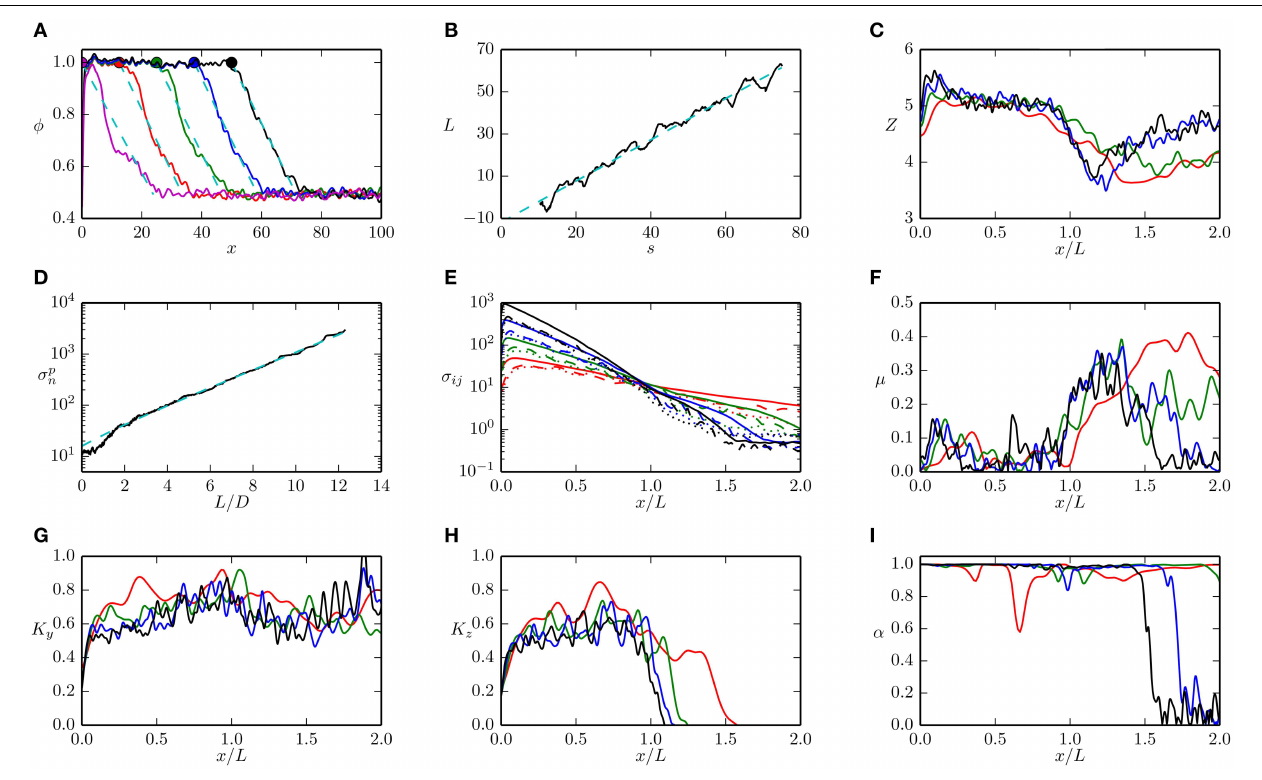
indicates the best linear fit to these points. (C) The coordination number, Z , as a function of normalized distance from the piston head, x / L . (D) Normal stress measured at the piston is shown in black. The cyan dashed line indicates the best fit estimate of Equation (6). (E) Normal stress distributions within the packing. Solid lines indicate σ xx , dashed σ yy and dotted σ zz . (F) Apparent friction coefficient measured within the packing, µ = | σ xz | /σ zz . (G) Out of plane Janssen coefficient measured within the packing, K y = σ yy /σ xx . (H) In plane vertical Janssen coefficient measured within the packing, K z = ( σ zz − ρ p ν gD / 2) /σ xx . (I) Absolute value of the x component of the eigenvector of the major principal